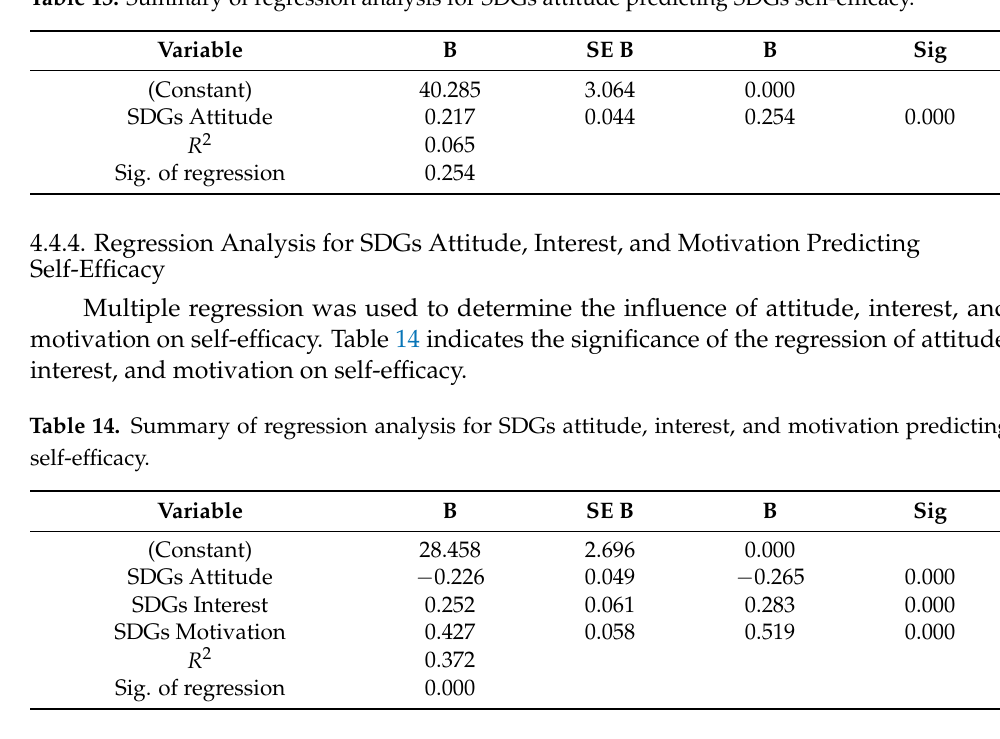
Table 13. Summary of regression analysis for SDGs attitude predicting SDGs self-efficacy.